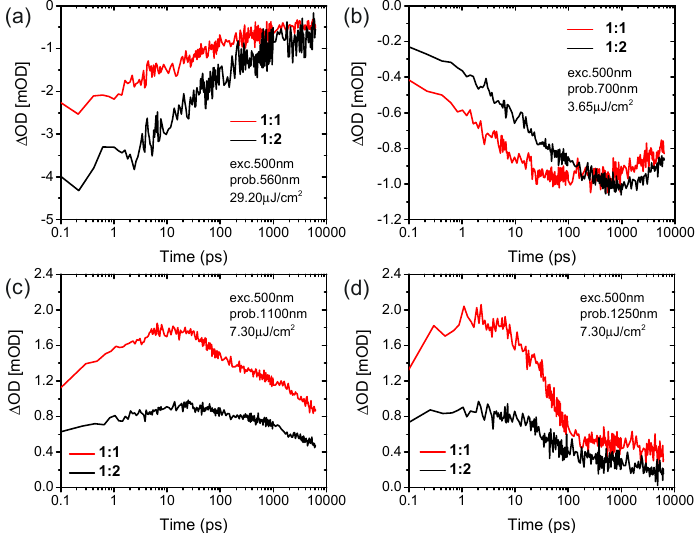
Figure 4. fs-Transient absorption dynamics at selected probe of blends of PffBT4T-2OD:TP of 1:1 and